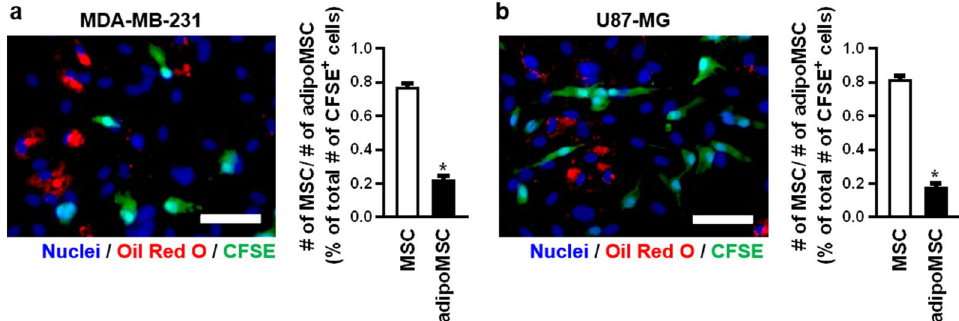
Figure 6. Adipogenic differentiated mesenchymal stem cells (adipoMSC) show less interaction with cancer cells. The CFSE-labelled cancer cell lines MDA-MB-231 and U87-MG were seeded on a confluent layer of adipogenic differentiated bmMSCs with a percentage of differentiation of approximately 50% and incubated for 24 h. Number of differentiated bmMSCs was microscopically evaluated. Nuclei were stained with Hoechst 33342 (blue), and lipid vesicles of adipogenic differentiated bmMSCs were stained with Oil Red O (red). The localisation of the cancer cells (blue and green) in comparison to native bmMSCs (blue; MSCs)